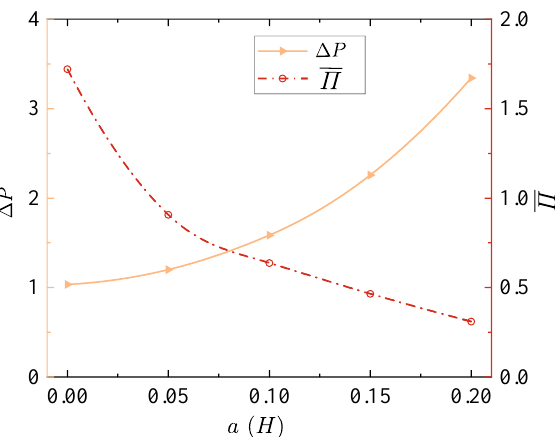
Figure 12. Mean apparent viscosity at the outlet of the test section ( 𝛱̅ ) and dimensionless pressure drop of the test section ( ∆𝑃 ) for different wave amplitudes. The length of the wave is 2𝐻 , and 𝑅𝑒 gen,CY is 130.